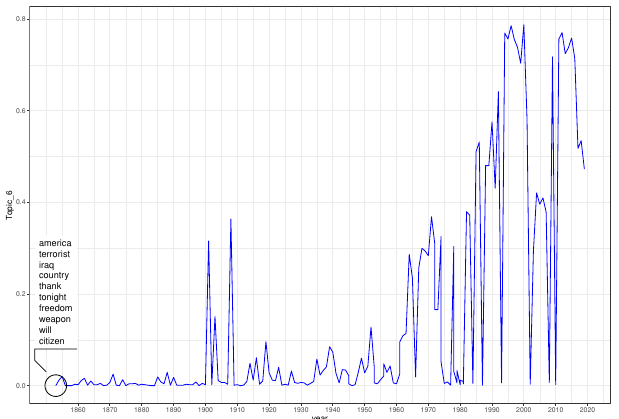
Figure 8. Evolution of Topic 5 proportions in SOTU speeches ( Topic Scaling ).